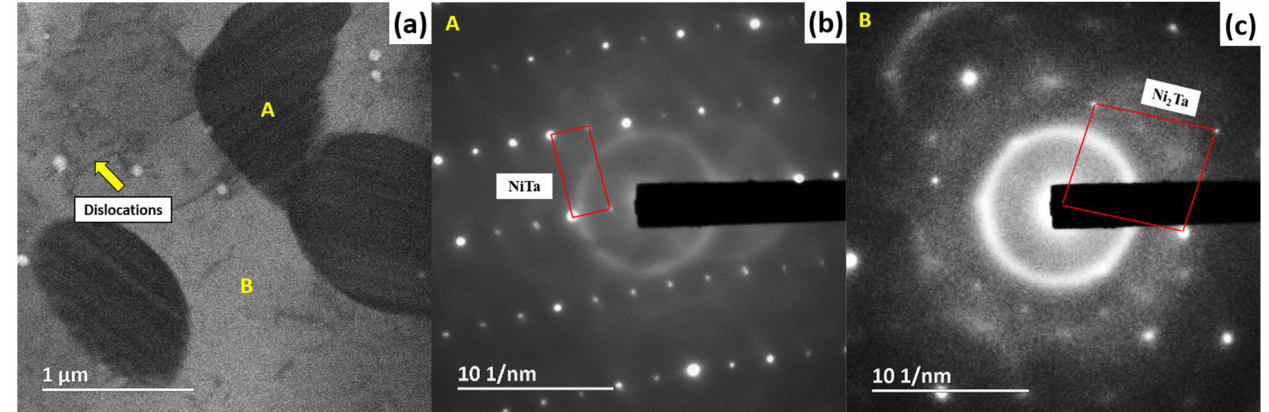
Figure 20. TEM micrographs of an annealed specimen. ( a ) Low-magnification dark-field image; ( b ) SAED pattern of primary phase “A” in [111] direction; ( c ) SAED pattern of secondary phase “B” in [111 ] direction.